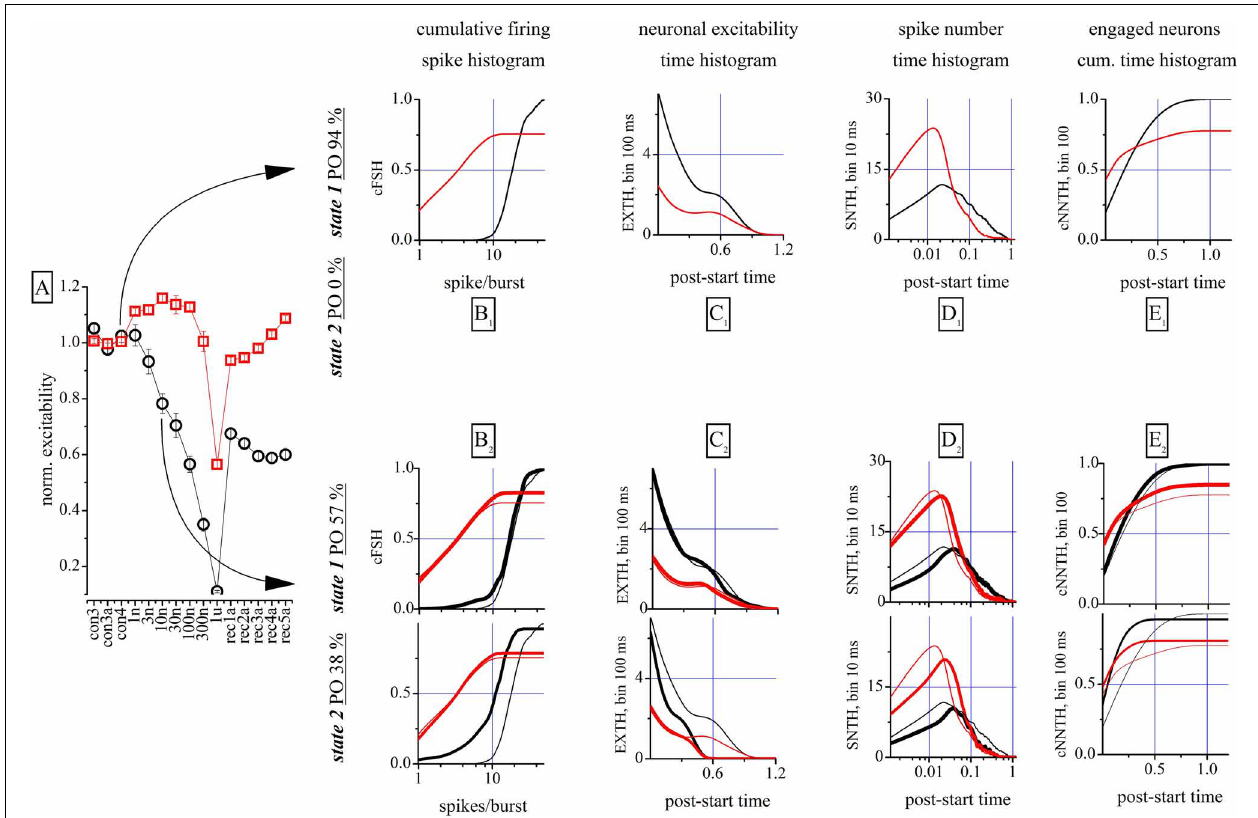
FIGURE 3 | Properties of the analysis of the network states. (A) Global dose–response effects ofTHDOC obtained without the use of the “state” analysis. Arrows indicate the two time segments that were analyzed by using the “state” analysis. Only one state was identified in control, but in the 10 nM segment two states were identified. Red and black symbols show data derived from identified excitatory and inhibitory neuron clusters. (B 1 ,C 1 ,D 1 ,E 1 ) Plot of cFSH, EXTH, SNTH and NNTH histograms, respectively, during the control segment.The cumulative firing spike histogram (cFSH) plots describe how the number of spikes/burst are distributed in the excitatory or inhibitory clusters of neurons (left).The excitability time histogram (EXTH) provides a characterization in the time-domain (bins of 100 ms), about the average number of spikes elicited by